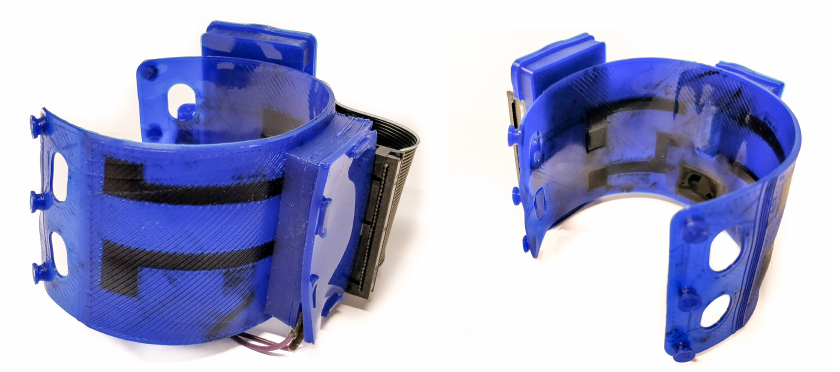
Figure 18. Proof of concept custom-sized 3D-printed EMG armband. The electrodes are internally routed to an EMG amplifier fitted in a housing integrated in the